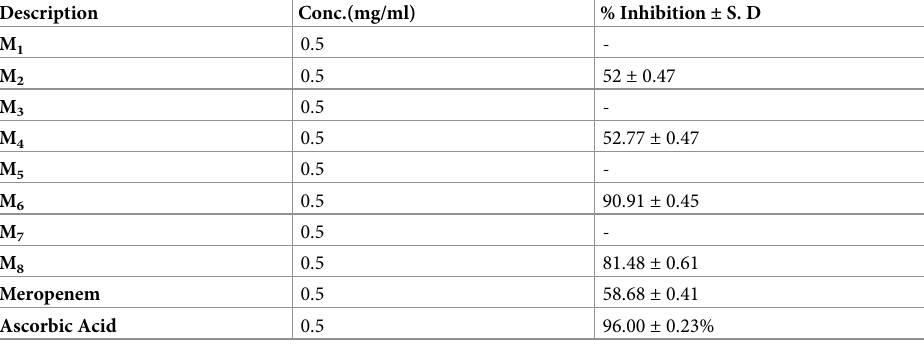
Table 3. DPPH radical scavenging activity of meropenem, its derivatives (M 1 -M 8 ) and ascorbic